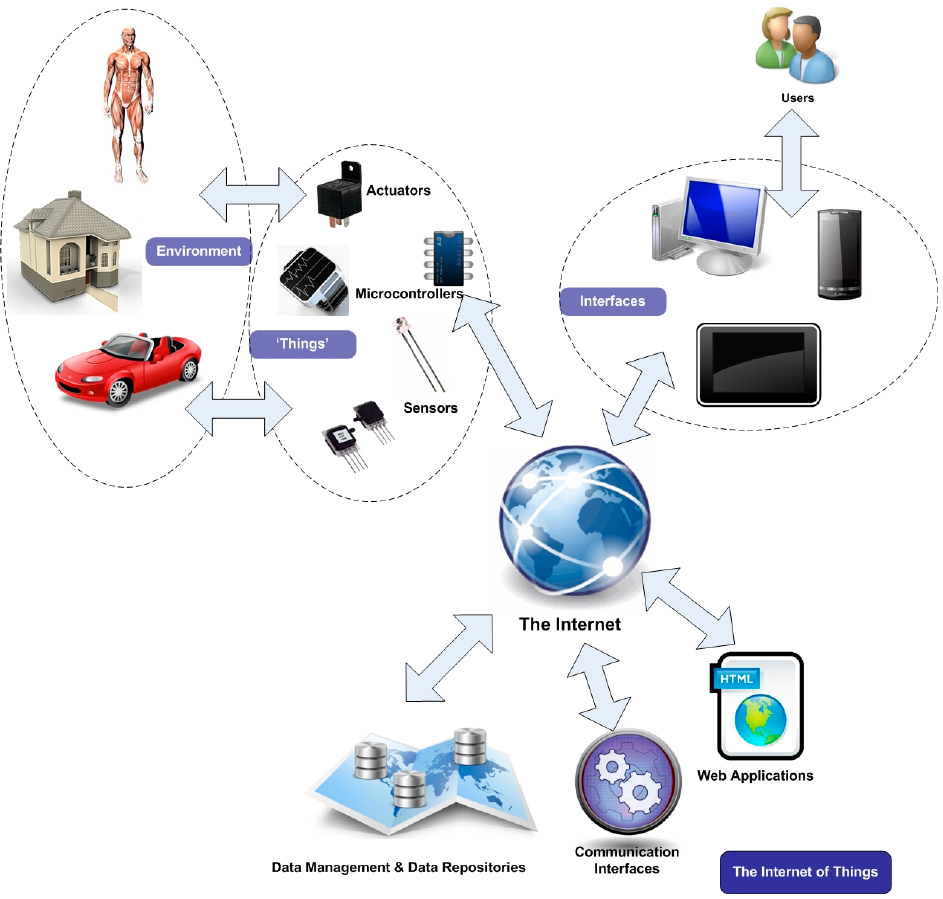
Figure 1. Interactions in the Internet of Things [9] (http://www.buildinginternetofthings.com). Reproduced with permission with [9]. Createspace Independent Publishing Platform, 2012.